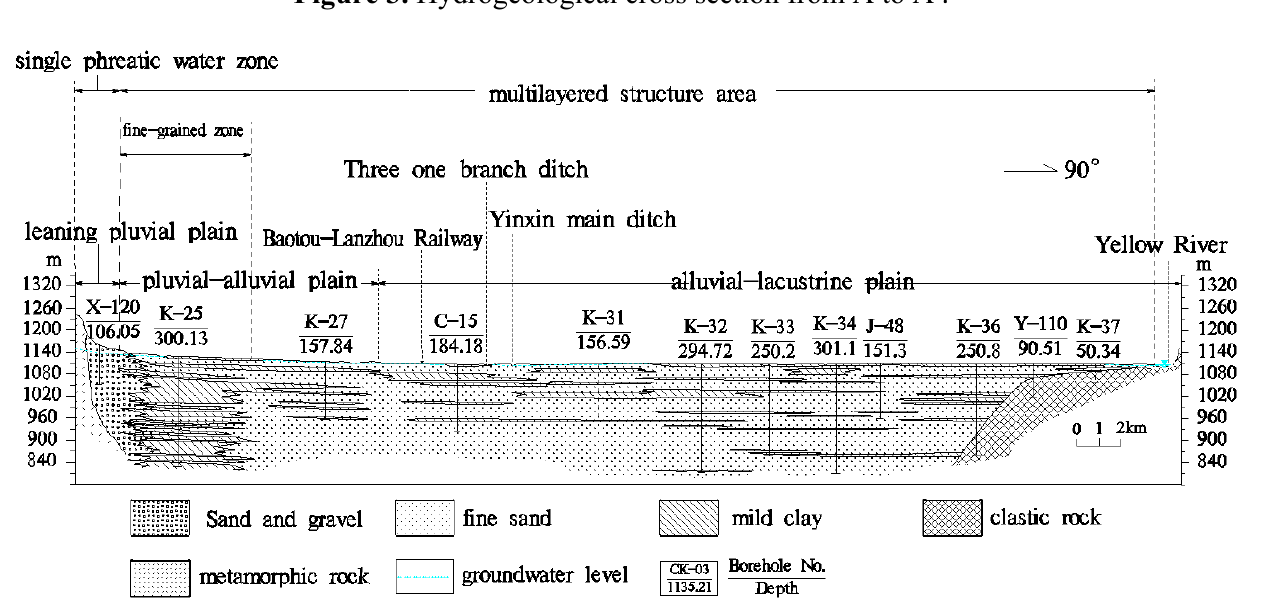
Figure 3. Hydrogeological cross section from A to A